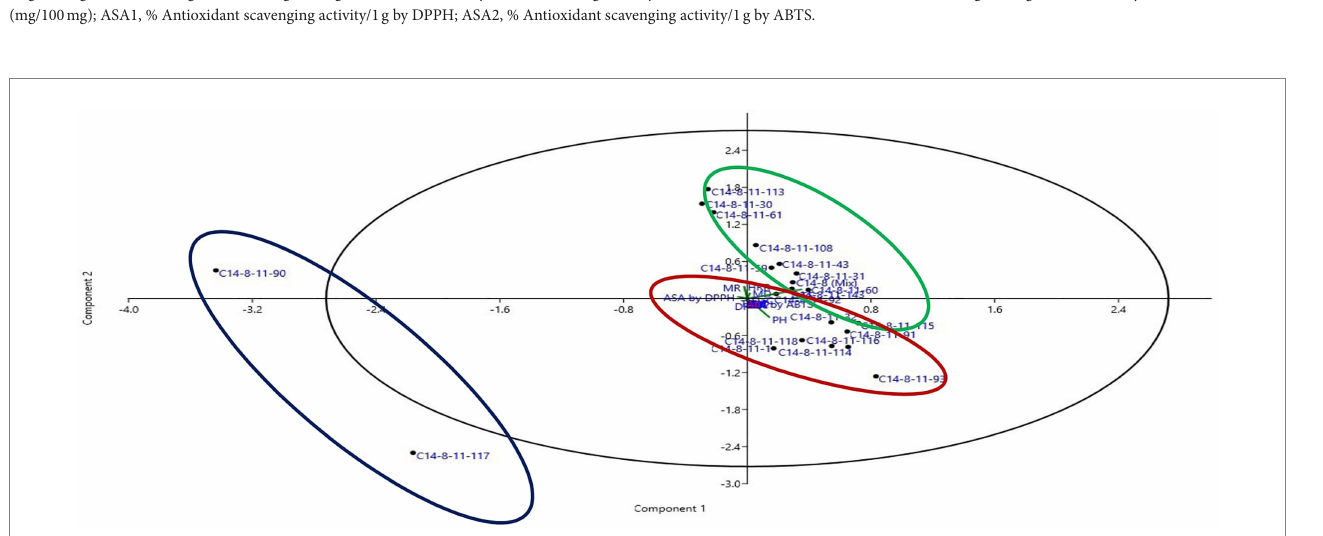
FIGURE 5 Two-dimensional scatter plot of PCA ordination using two most informative axis of 21 selected C14-8 rice lines obtained through PCA